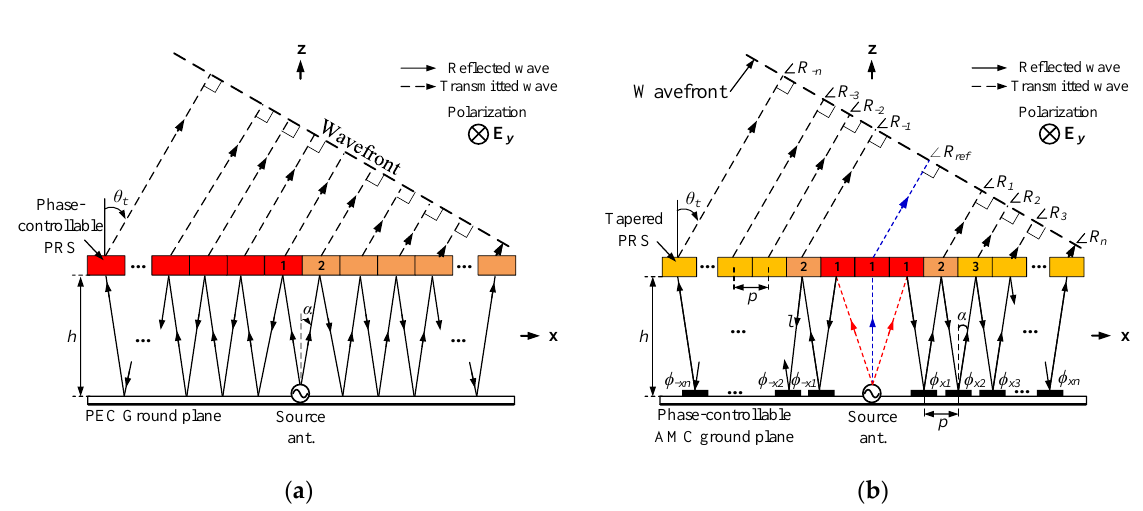
Figure 2. Beam scanning principles of (a) a conventional FPC antenna, and (b) the proposed FPC antenna. To obtain a directional beam in the target direction, transmitted fields should be in-phase on the target wavefront.